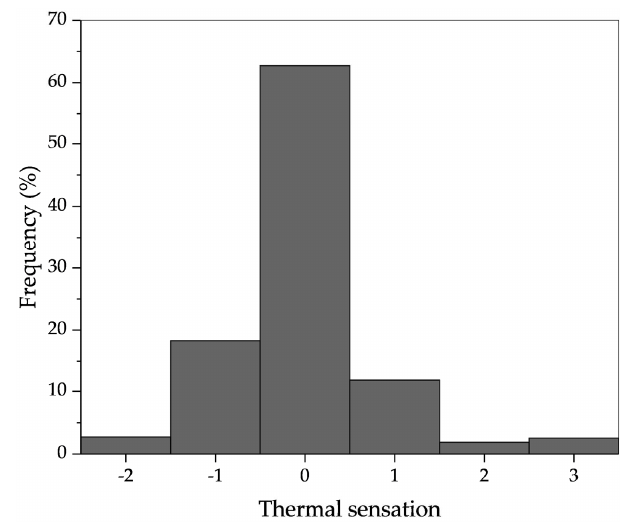
Figure 5. Distribution of thermal sensation vote.